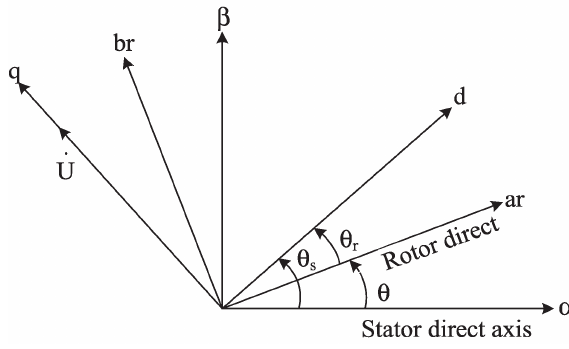
Fig. 2. Reference frames and space vector